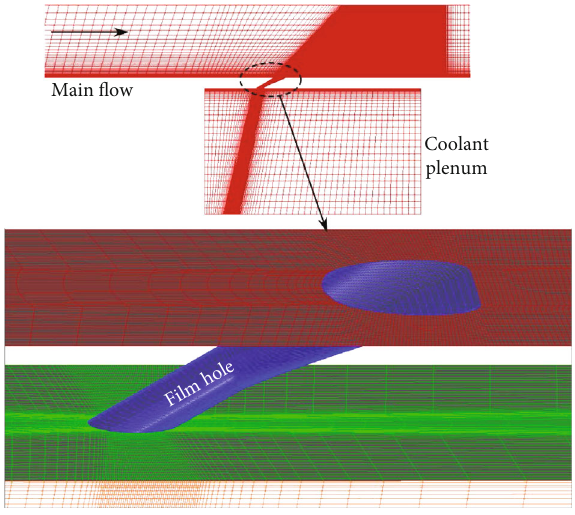
Figure 7: Computational model and mesh distribution around a typical fi lm hole ( Geometry c